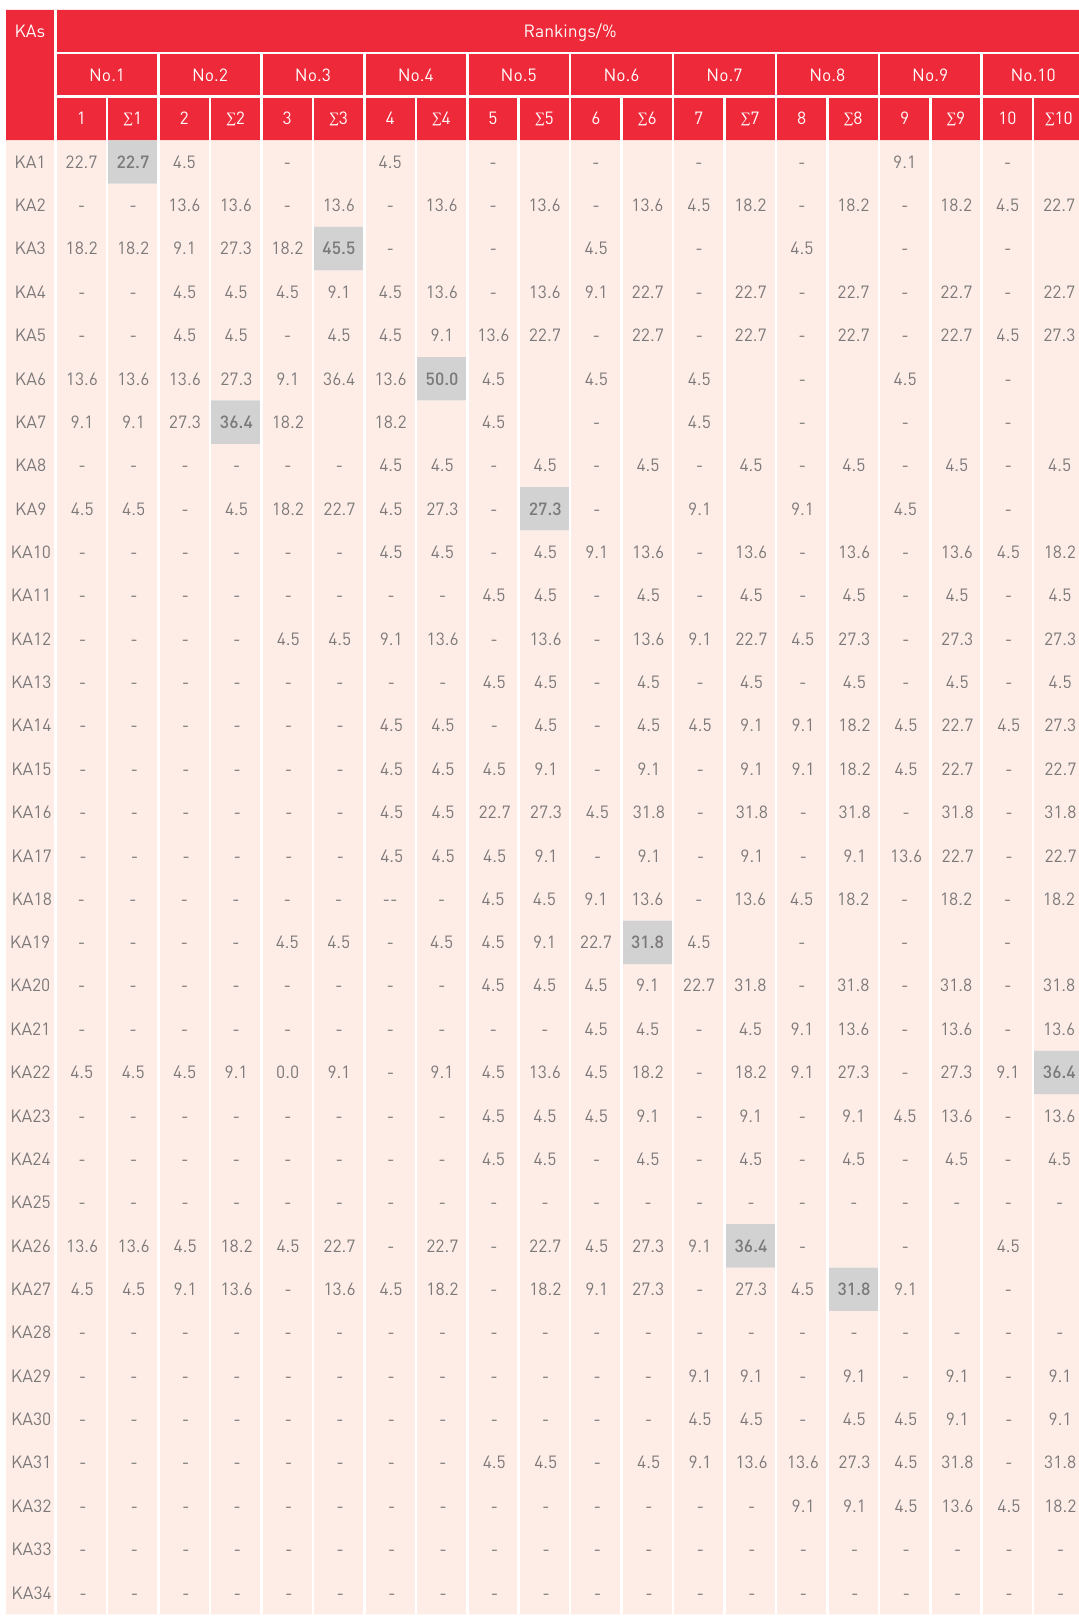
Ranking of attributes based on